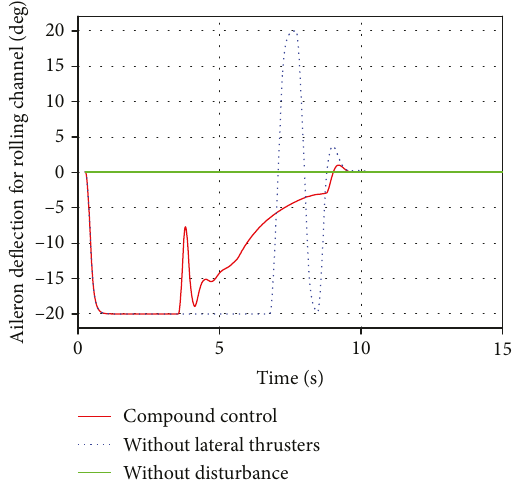
Figure 7: Variation of aileron de fl ection in the initial stage of launch.